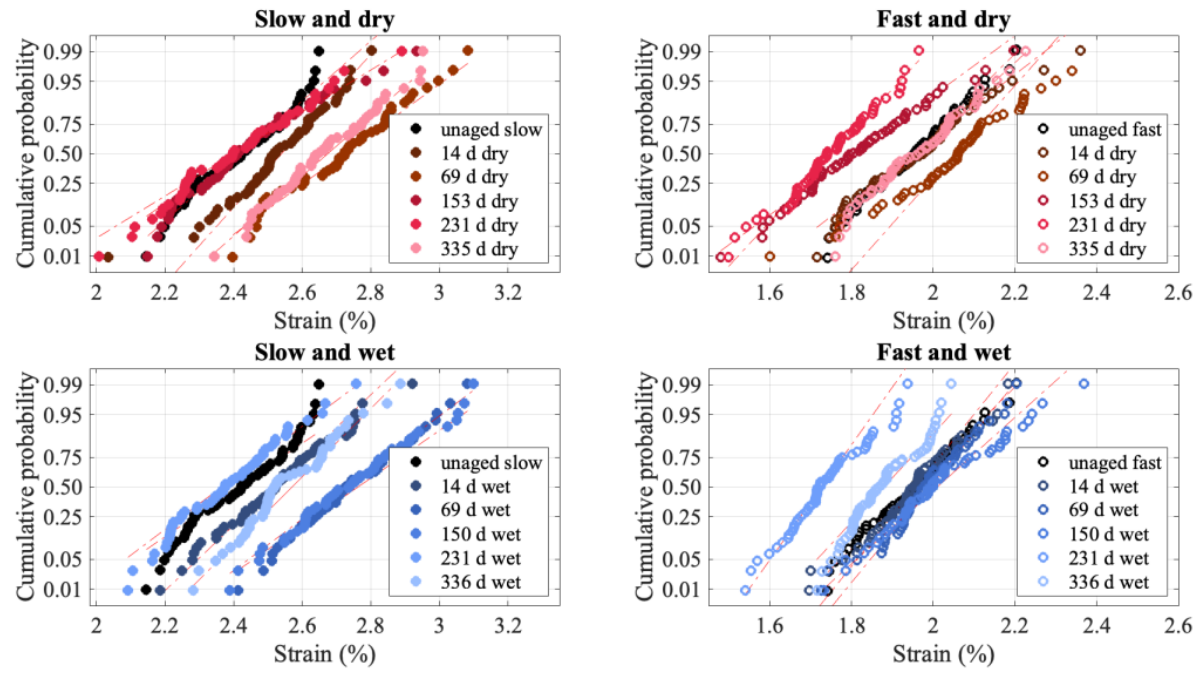
Figure 12. Normal probability plots for failure strain.